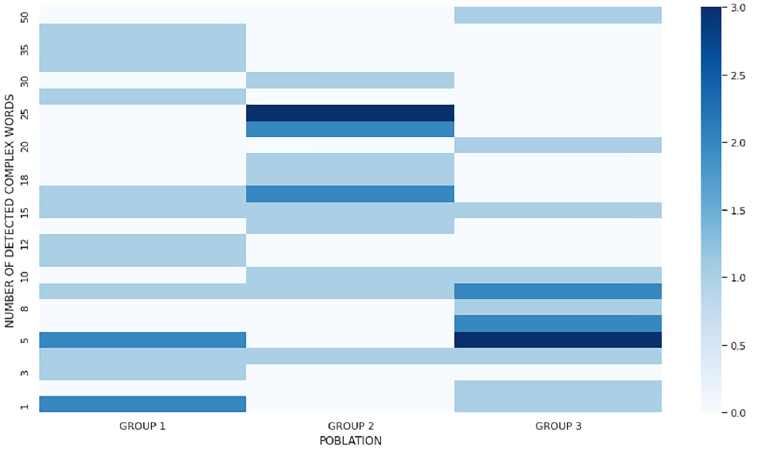
Fig 5. Number of detected complex words, divided by groups, where Group 1: older people, Group 2: people with intellectual disabilities and Group 3: control users.